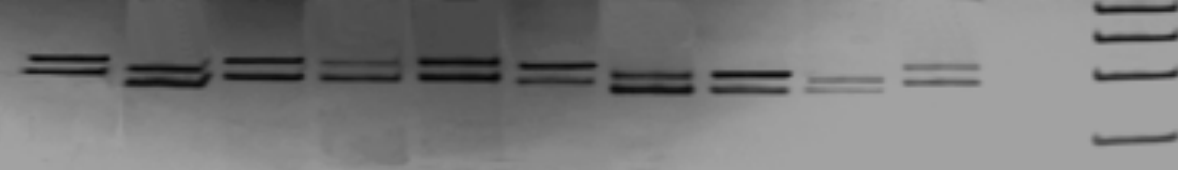
Figure 2. Representative DNA polymorphism among ten selected strains of Fusarium culmorum detected by microsatellite primer pair F9. Lanes from left to right: strains 1 and 2 from Lorestan; 3 and 4 from Tehran; 5 and 6 from Golestan; 7, 8, 9, and 10 from Qazvin-East Azarbaijan populations; Co - , negative control; M, 100-bp Ladder as the DNA size